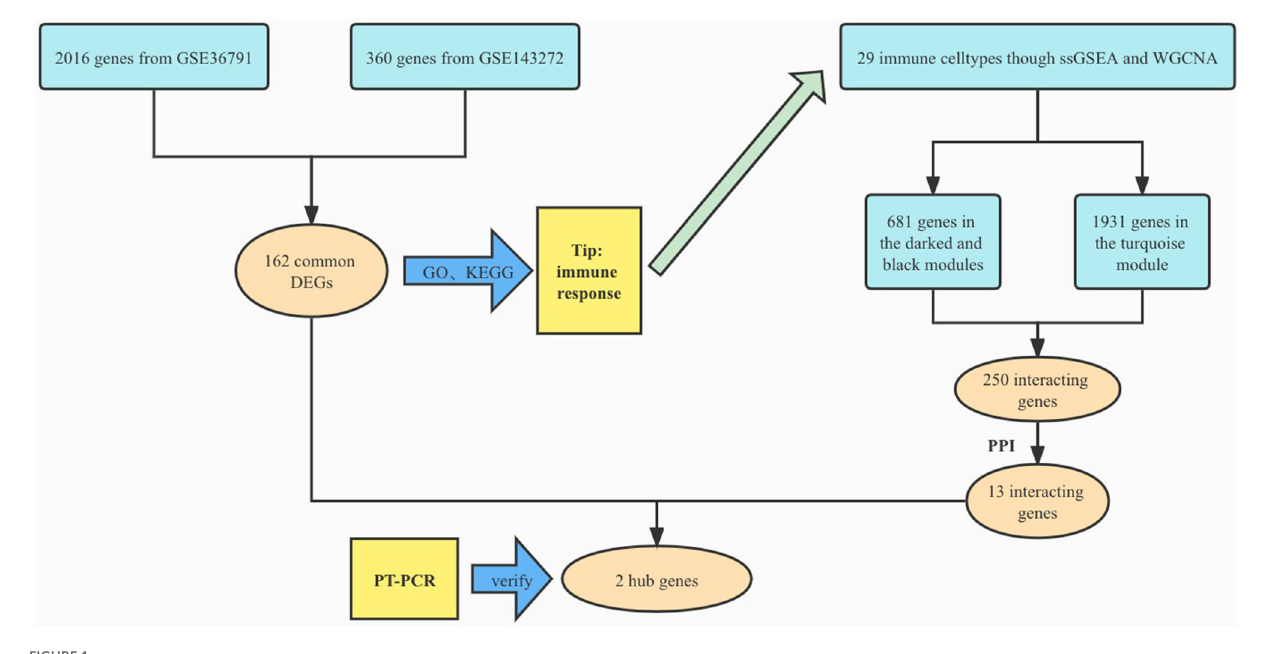
FIGURE1 Study flowchart.